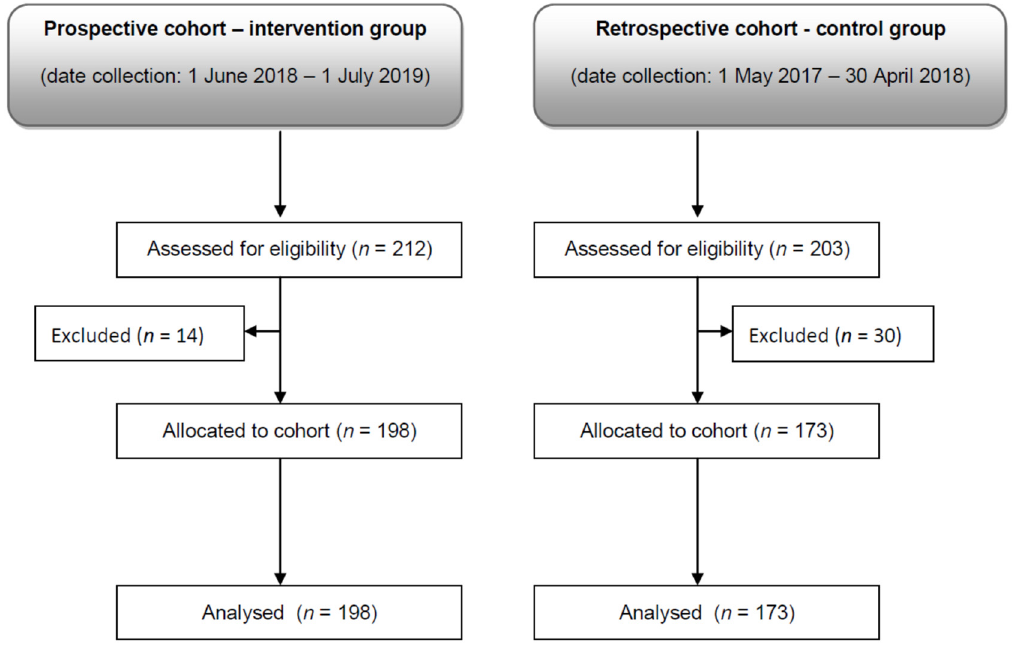
Figure 1. Flow diagram.